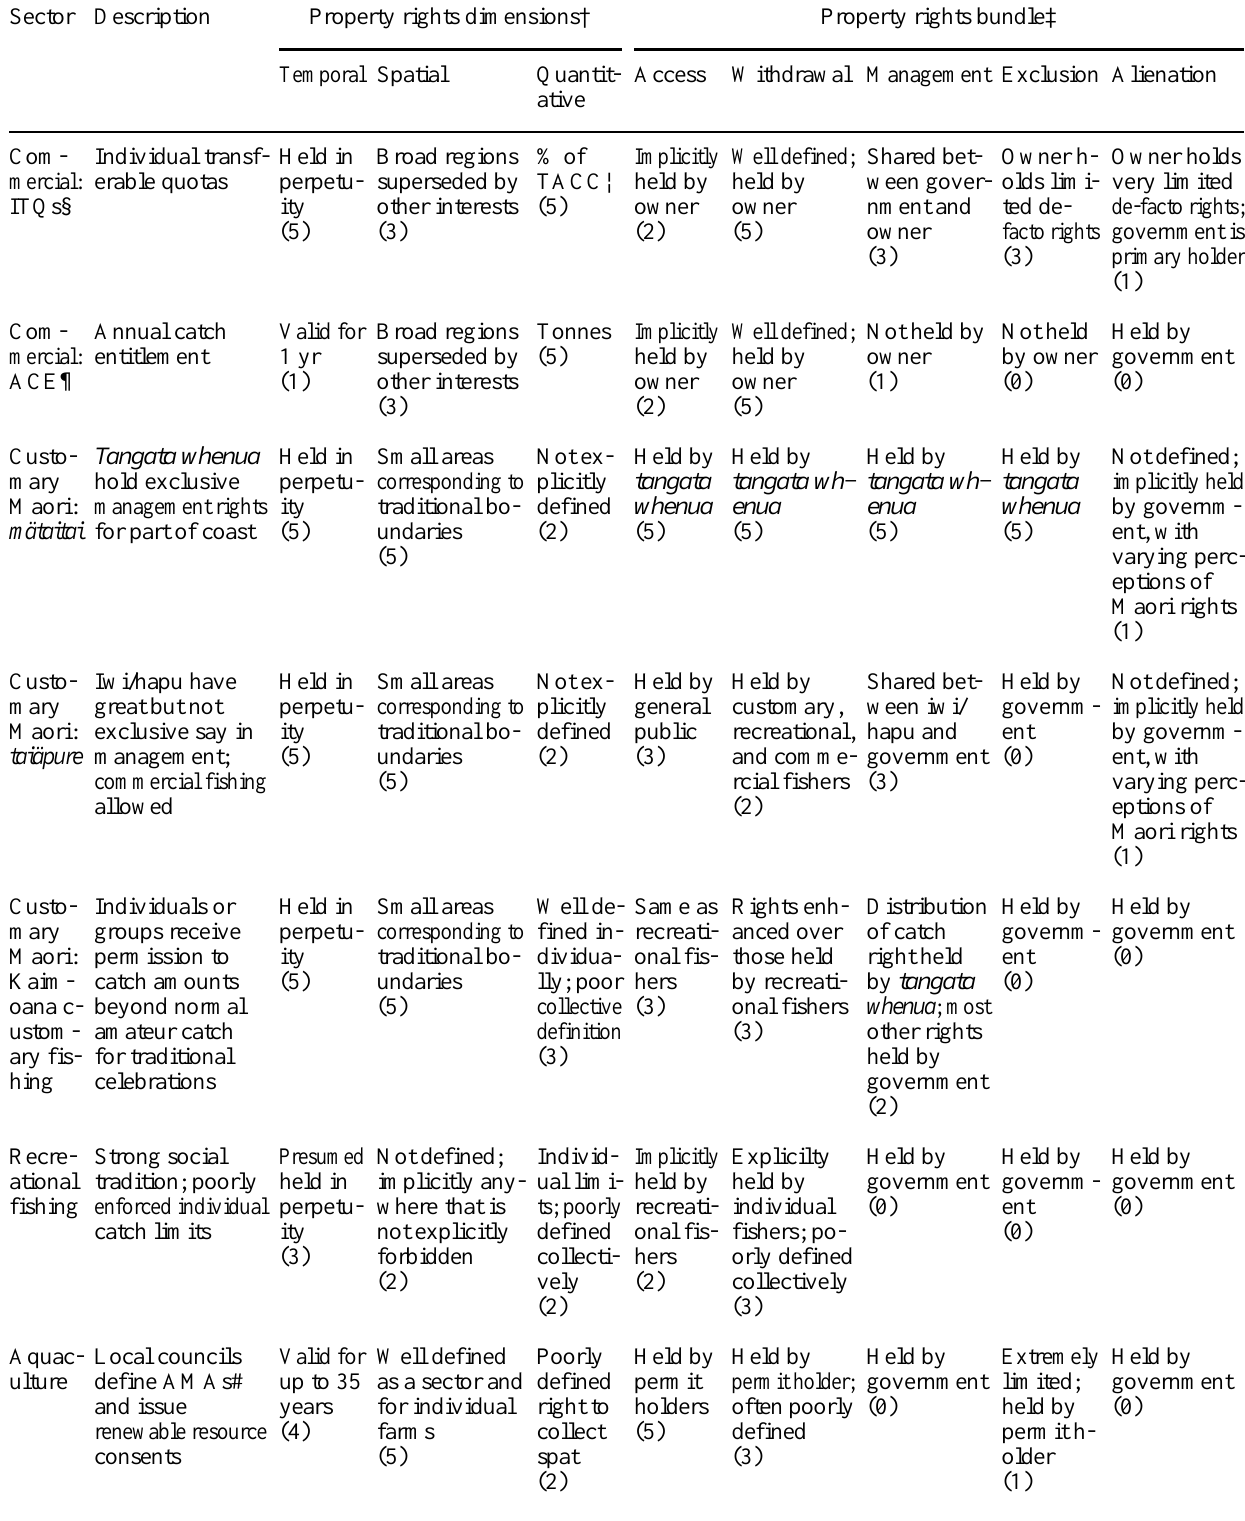
Table 1. Summary and analysis of New Zealand marine resource interests and property rights